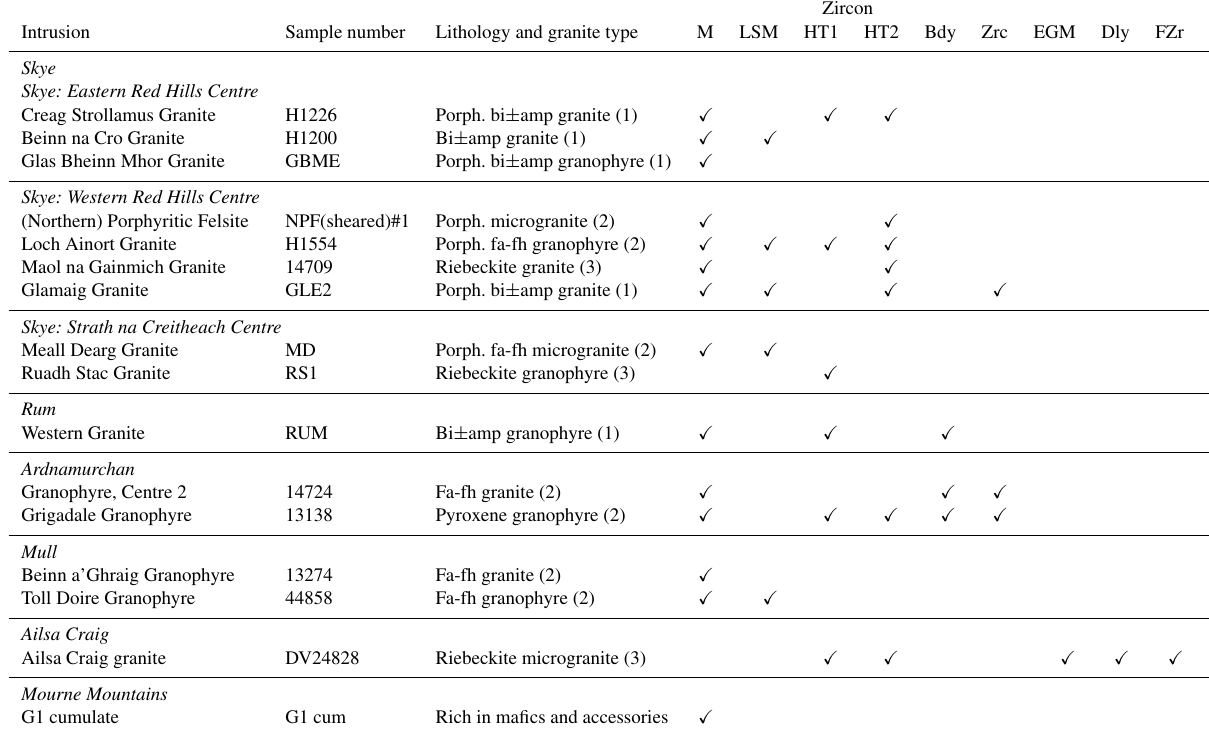
Table 1. Location and lithology of the Paleogene granites used in this study and occurrences of Zr